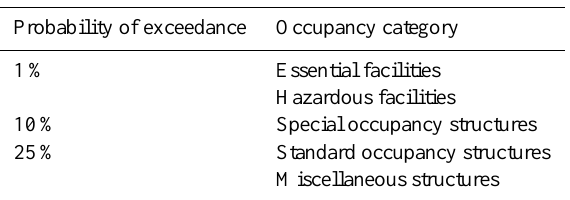
Table 3. Assigned probability of exceedance for every occupancy